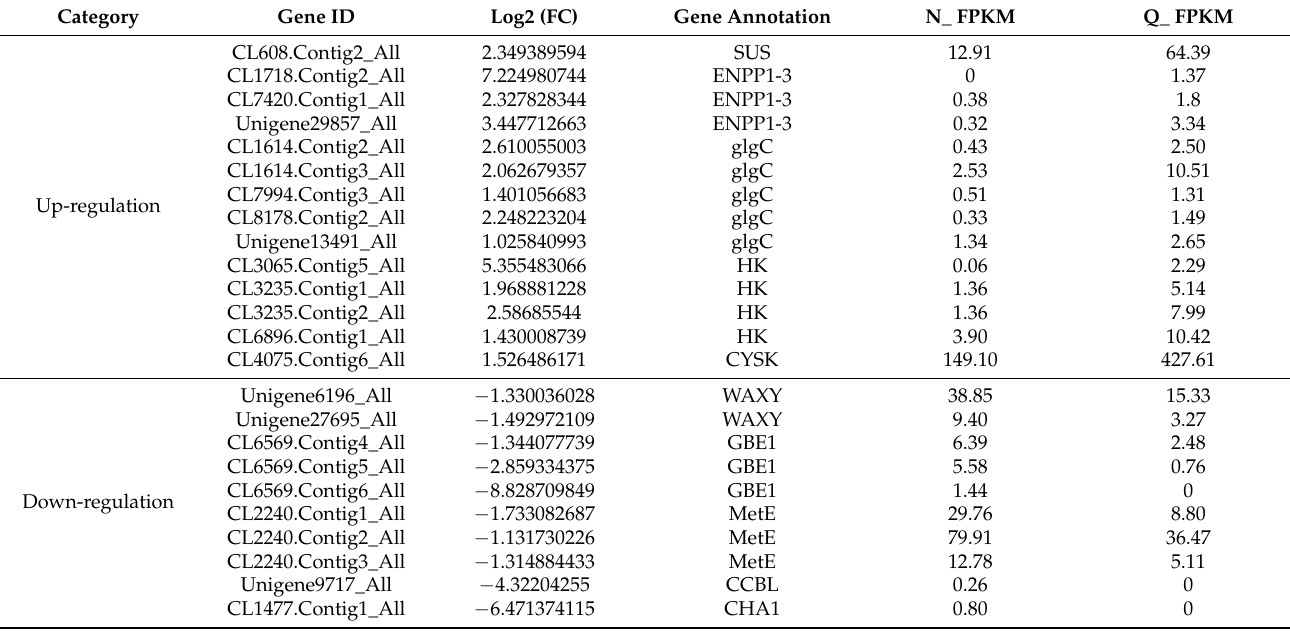
Figure 4. Simplified model of metabolic pathways in heatmap of expression patterns of R. chrysanthum-related differentially expressed genes (DEGs) under UV-B irradiation. Filtering of DEGs by log2 FPKM (transcript fragments per kilobase per million mapped reads). Blue and red boxes indicate gene down-regulation and up-regulation, respectively. HK: hexokinase; PSPH: Phos- phoserine phosphatase; metE: methyltransferase; SUS: sucrose synthase; glgA: starch synthase; GBE1: 1,4- α -glucan branching enzyme; WAXY: granule-bound starch synthase; glgC: glucose-1-phosphate adenylyltransferase; ENPP1-3: ectonucleotide pyrophosphatase/phosphodiesterase family mem- ber 1/3; CysK: serine O-acetyltransferase; CCBL: cysteine-S-conjugate beta-lyase; CHA1: L-serine/ L-threonine ammonia-lyase. Green and red borders indicate down-regulation and up-regulation of metabolites, respectively). Table 3. Up-regulated and down-regulated genes of R. chrysanthum amino acid metabolism and carbohydrates metabolism under UV-B